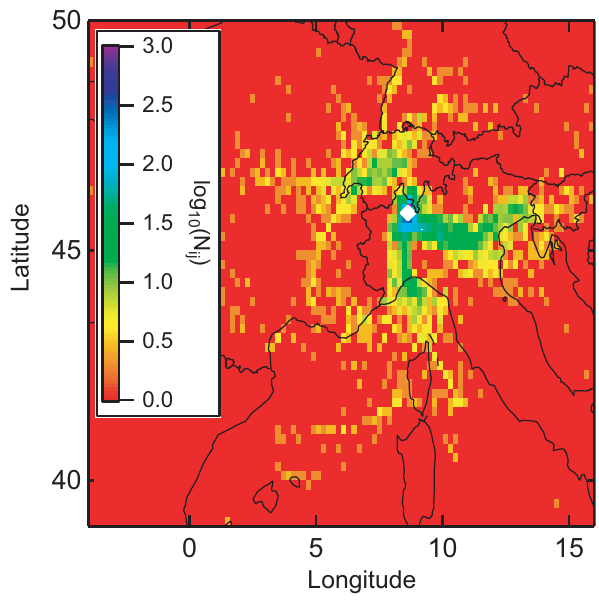
Fig. 2. Frequency distribution map (on a logarithmic scale) of back trajectory passes during aerosol collection periods.